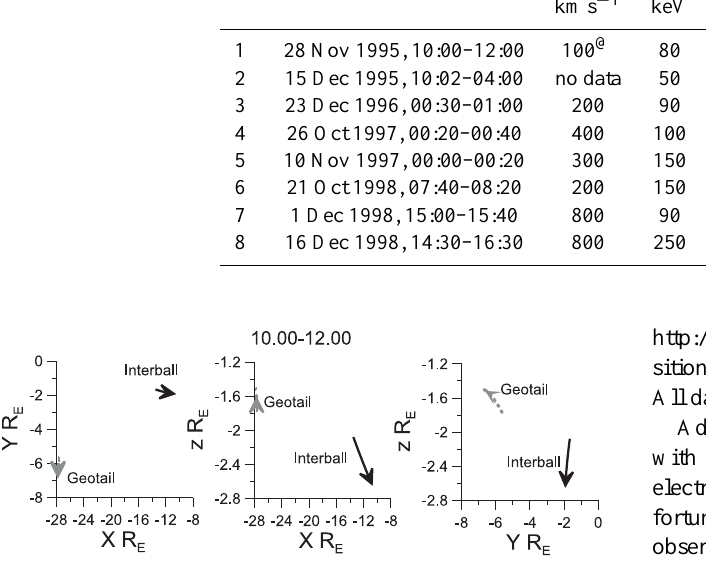
Fig. 7. Positions of Interball-tail and Geotail spacecraft on 28 November 1995 from 10:00 to 12:00.